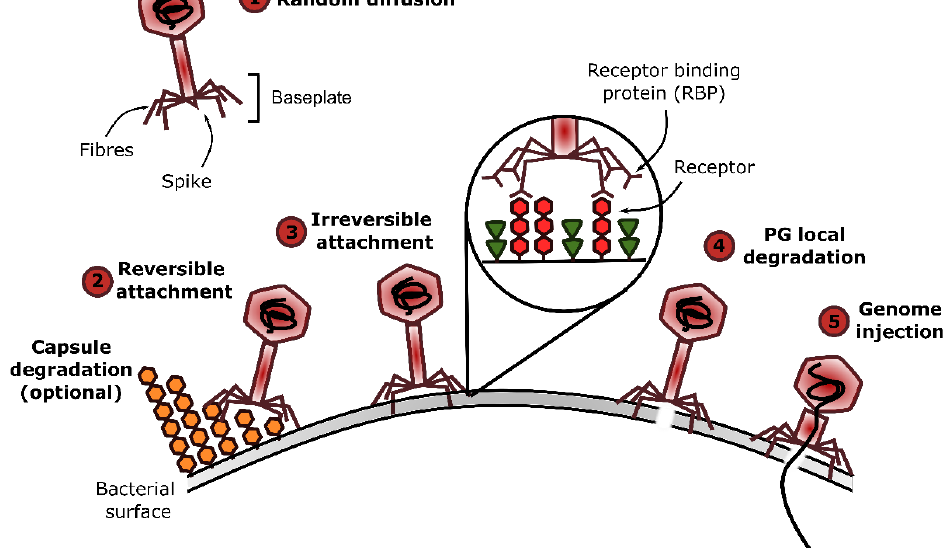
Figure 1. Phage adsorption process and events leading to genome injection. Phage adsorption to their host involves the interaction between Receptor Binding Proteins (RBP) located at the distal part of phage tails and receptors at the surface of the bacterial cell envelope. This process is divided into three steps: (1) random diffusion in the medium, (2) reversible attachment, and (3) irreversible attachment to the bacteria. The adsorption can be assisted by depolymerases cleaving capsular polysaccharides that can hamper receptor access. Following adsorption, virion-associated lysins may locally break down the PG (4) and, finally, conformational changes in the virion structure lead to genome injection (5). This figure was made with the open-source software Inkscape.